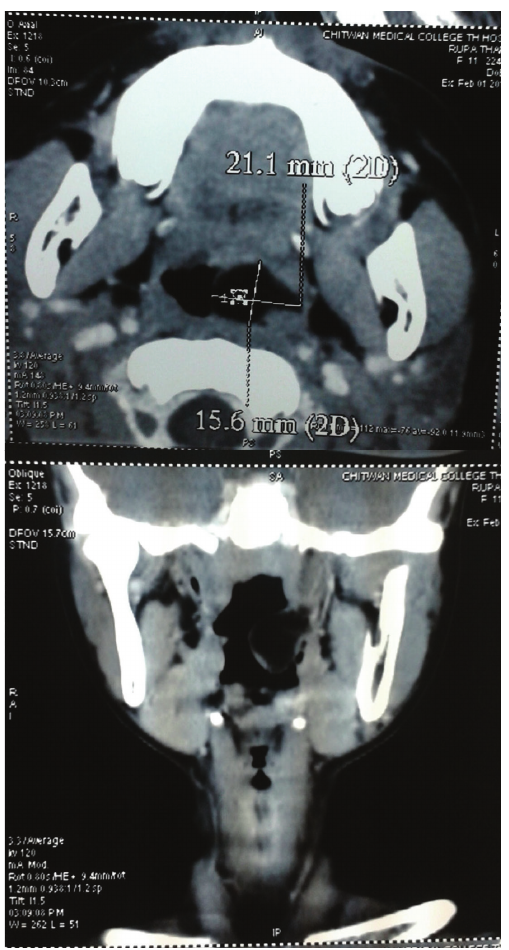
Figure 2: CT scan showing the soft tissue mass in the nasopharynx (nasopharyngeal mass) (axial and coronal view).